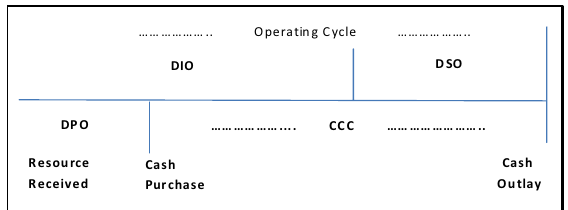
Fig. 1. Cash conversion